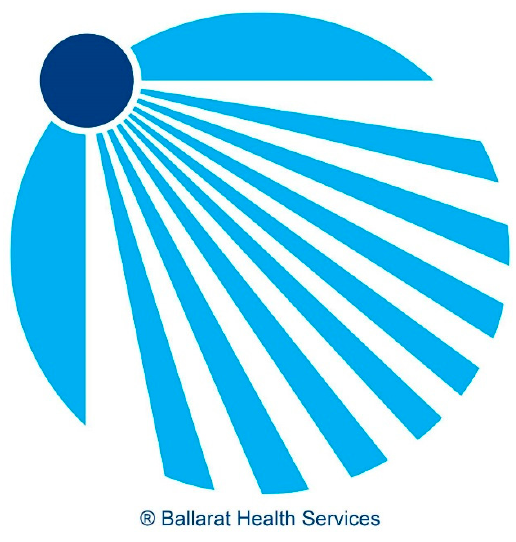
Figure 1. Cognitive Impairment Identifier (CII).